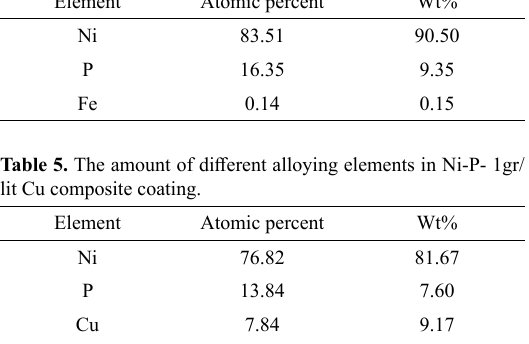
Table 4. Weight percent and atomic percent of Ni and P present in the Ni-P electroless coating. Element